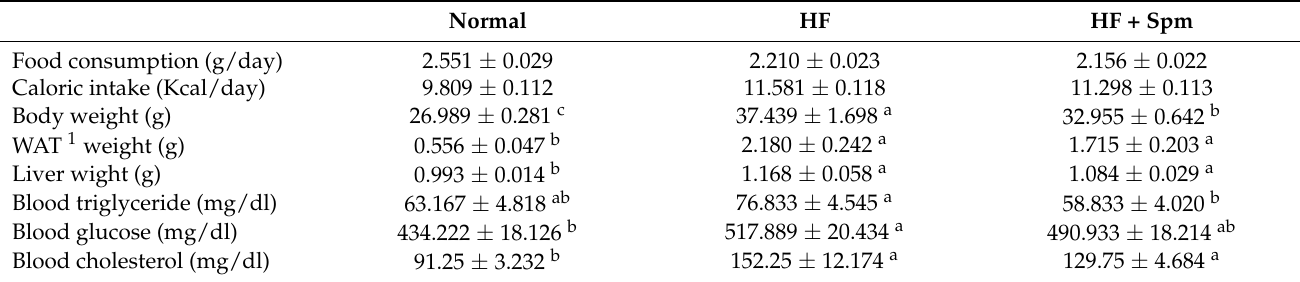
Figure 3. Effect of Spm on the expression of differentiation-related genes in 3T3-L1 cells: ( A ) Expres- sion of Cebpd mRNA on days 1 and 2 of culturing in differentiation medium; ( B ) Expression of Cebpa mRNA on days 4 and 7 of culturing in differentiation medium; ( C ) Expression of PPARgamma mRNA on days 4 and 7 days of culturing in differentiation medium. Data are shown as means ± S.E. derived from three independent experiments; each experiment was carried out in 3 culture wells. Statistics were compared between C group and Spm group by day. Student’s t -test, ** p < 0.01. Table 1. Description of food intake, organ weights, and serum parameters.